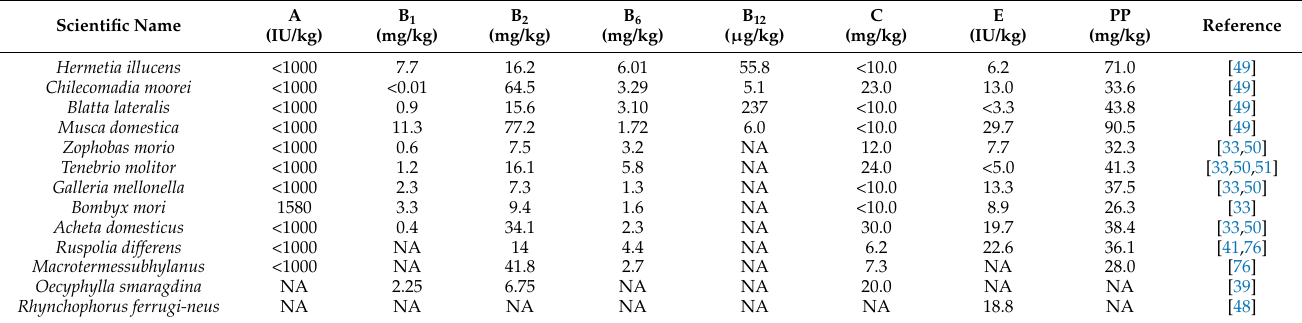
Table 4. Vitamin composition and content of